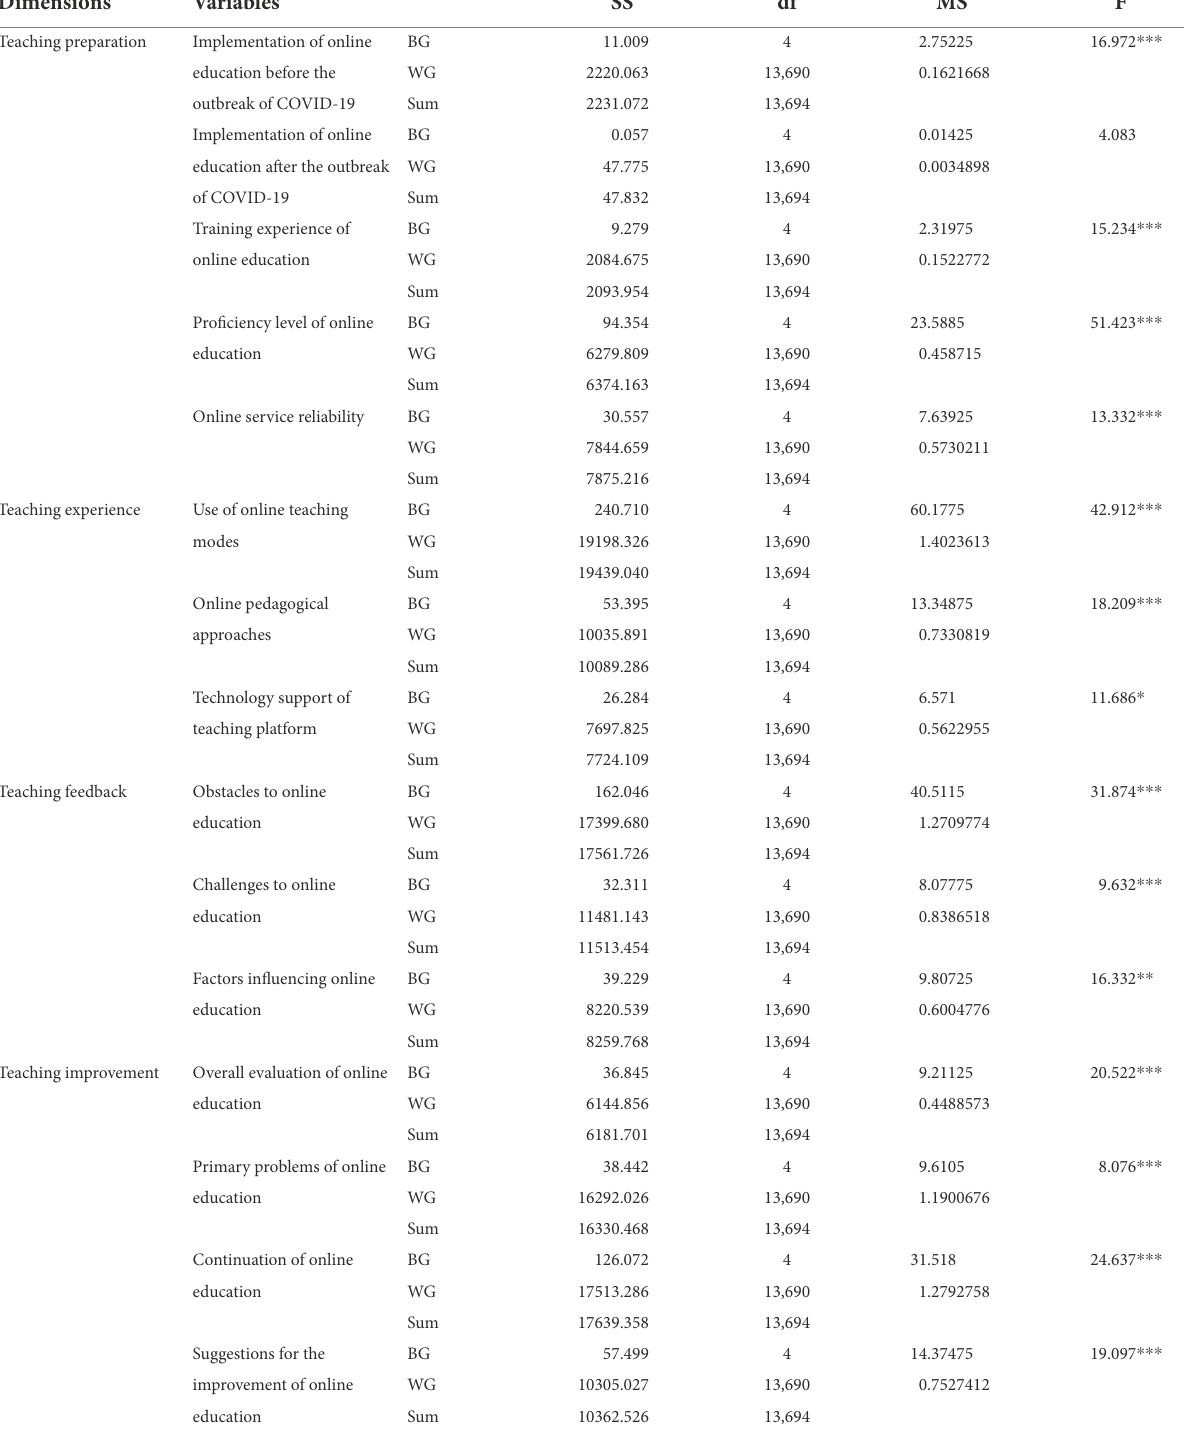
TABLE 6 Difference test of teachers’ online education of different